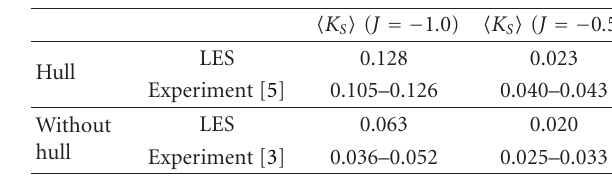
Table 2: Statistics of unsteady loads for open propulsor w/ and w/o hull.